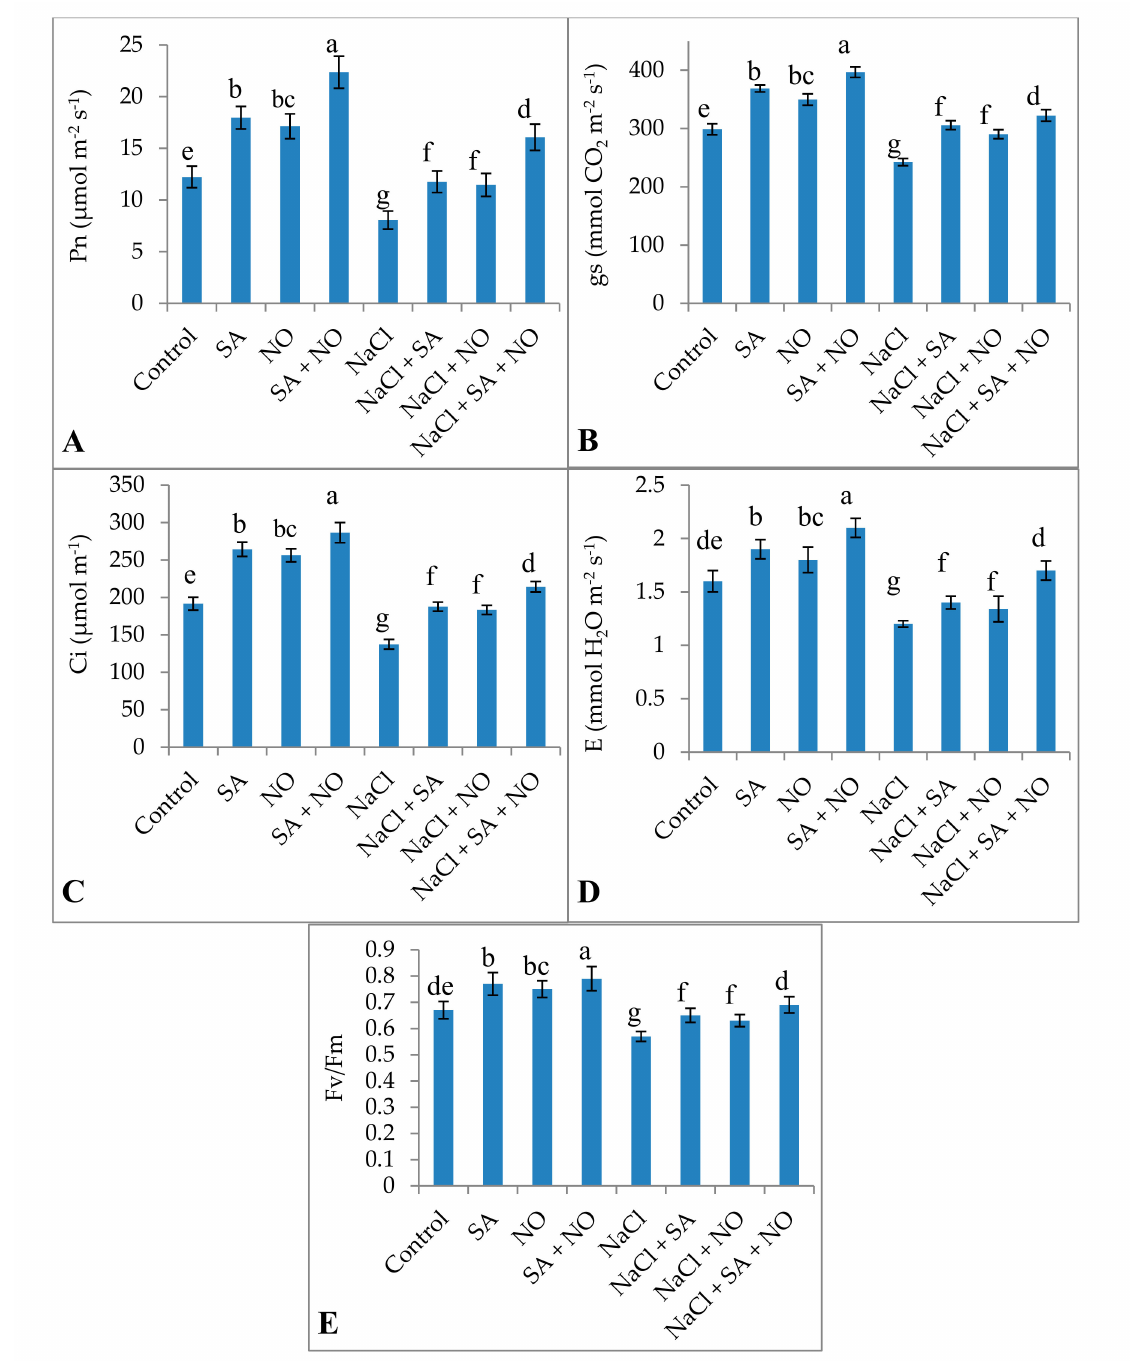
Figure 2. E ff ect of exogenous application of SA and NO on ( A ) net photosynthesis ( Pn ), ( B ) stomatal conductance ( gs ), ( C ) intercellular CO 2 ( Ci ), ( D ) transpiration ( E ) and ( E ) PSII activity (Fv / Fm) in Vigna angularis under salinity (100 mM NaCl) stress. Data are the mean of four replicates and di ff erent letters show significant di ff erence at p <